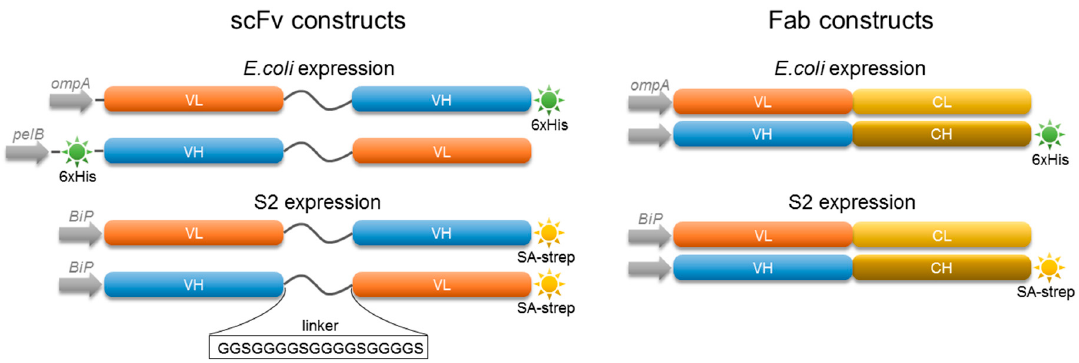
Figure 1. Schematic representation of 5D3 scFvs and Fab expressed by E. coli and insect S2 cells. Variants differ in the order of domains, the signal sequence and the type and position of an affinity tag. Signal sequences ompA, pelB, and BiP were inserted N-terminally to allow protein secretion. The SA-strep and 6×His tag positioned at either the N- or C- terminus were added for affinity purification. Variable domains of light (VL) and heavy (VH) chain were separated by an 18-mer linker identical in all scFv variants. Each Fab construct was composed of light (L) and heavy (H) chain consisting of variable (V) and constant (C) domain.